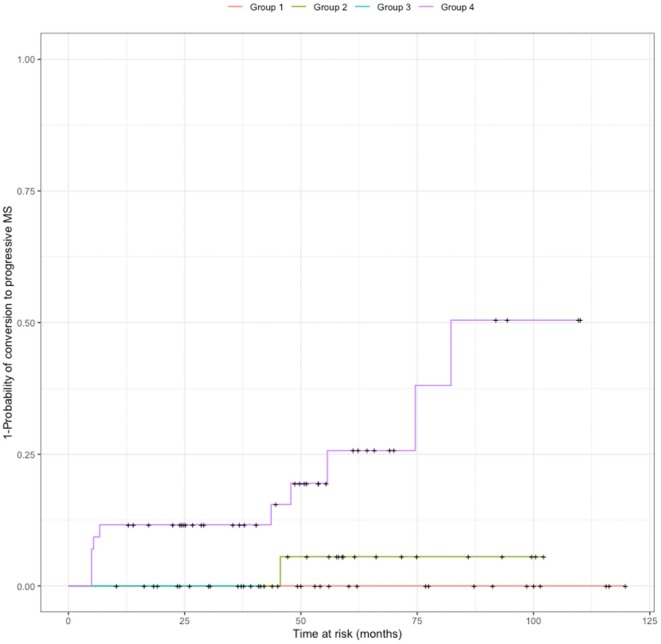
Probability of conversion to SPMS according to biomarker profile. Patients were cathegorized according to NFL and CHI3L1 median values (calculated in the RRMS cohort without disease activity) into four groups: Group 1: both NFL and CHI3L1 below median value; Group 2: high NFL; Group 3: High CHI3L1; Group 4: NFL and CHI3L1 above median values. Patients included in group 4 had more probability to be diagnosed of SPMS during follow-up than patients pertaining to the other groups (log rank p = 0.02). SPMS: secondary progressive multiple sclerosis.